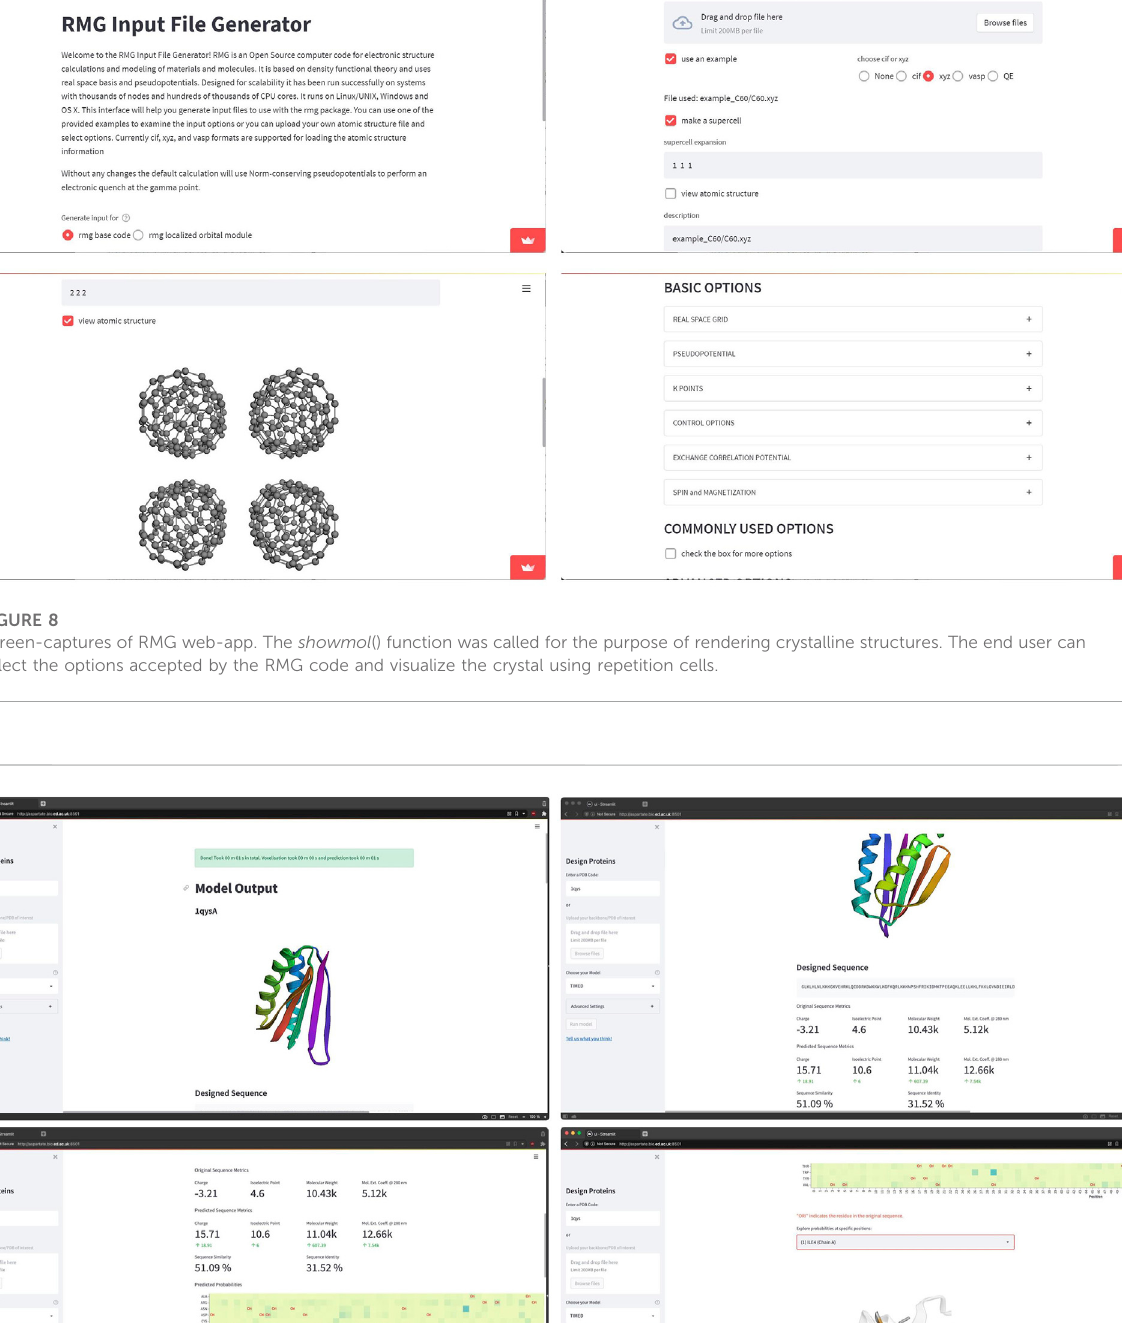
Frontiers in Molecular